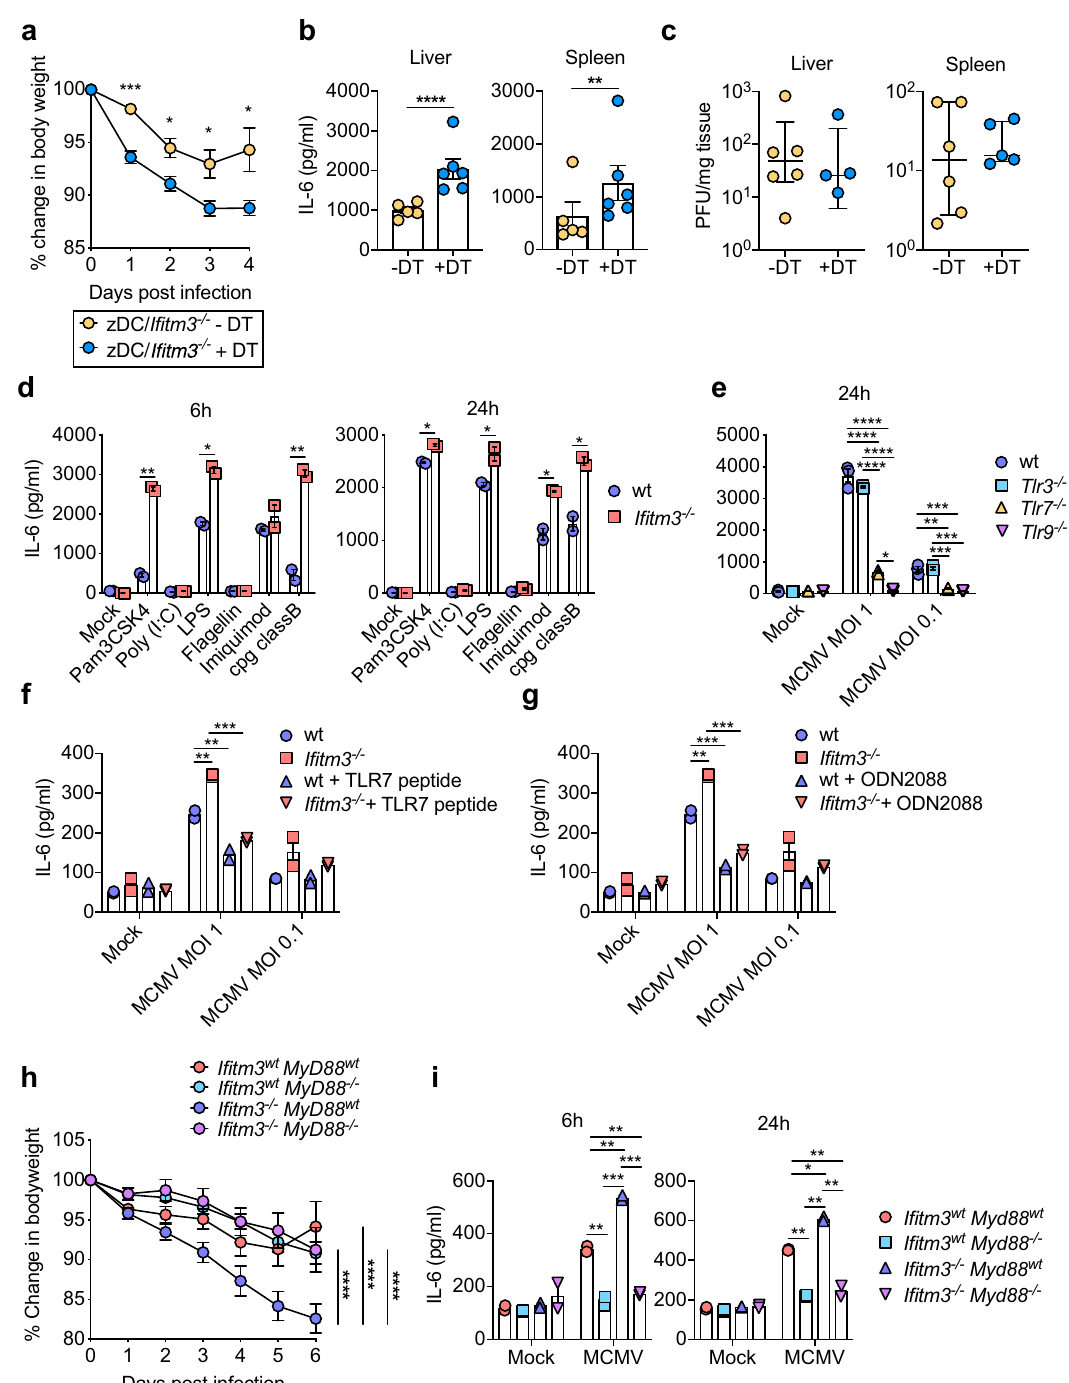
Fig. 1 | I fi tm3 enhances IL-6 downstream of TLRs and MyD88. Female mixed bone marrow chimeras with 50:50of I fi tm3 − / − and wt-zDC-DTRweregeneratedand treated ( n =6) or not ( n =5) with DT. a Mice were infected with 5×10 5 PFU MCMV and weight loss was assessed over time. Mean and SEM are shown. b 4 days p.i. spleensandliverswereharvestedfromMCMV-infectedmice,homogenised,andIL- and IL-6 in supernatants was assayed 6 and 24h post infection. f BM-DCs from wt and I fi tm3 − / − mice were pre-incubated with or without TLR7 synthetic blocking